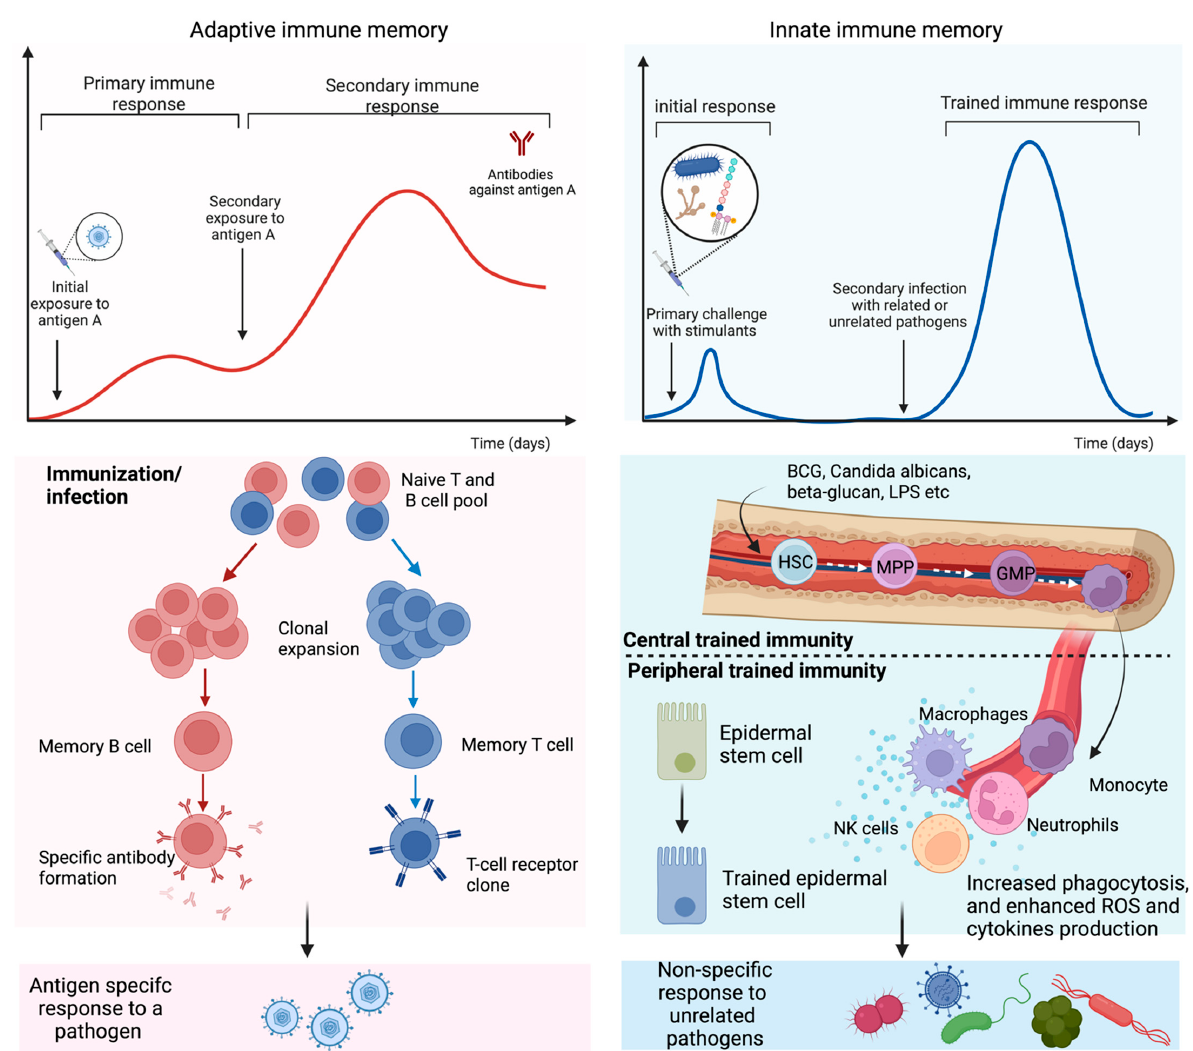
Figure 1. Adaptive and trained immune response. Exposure to antigens or pathogens may trigger innate and adaptive immune responses. In adaptive immunity, an antigen-specific response is at- tributed to antibody production and long-lived B and T lymphocytes by gene recombination and clonal expansion. Trained immunity is governed by a rapid and heightened innate immune response to certain vaccines and antigens that reprogram the hematopoietic stem cells (HSC) residing in the bone marrow or circulating innate immune cells. HSC undergoes differentiation to bone marrow precursors, multipotent progenitor (MPP), and granulocyte-macrophage progenitor (GMP) and consequently enters peripheral organs as circulating monocytes and tissue macrophages. Epithelial stem cells have also been identified as part of the peripheral trained immunity along with dendritic, NK, and endothelial cells.